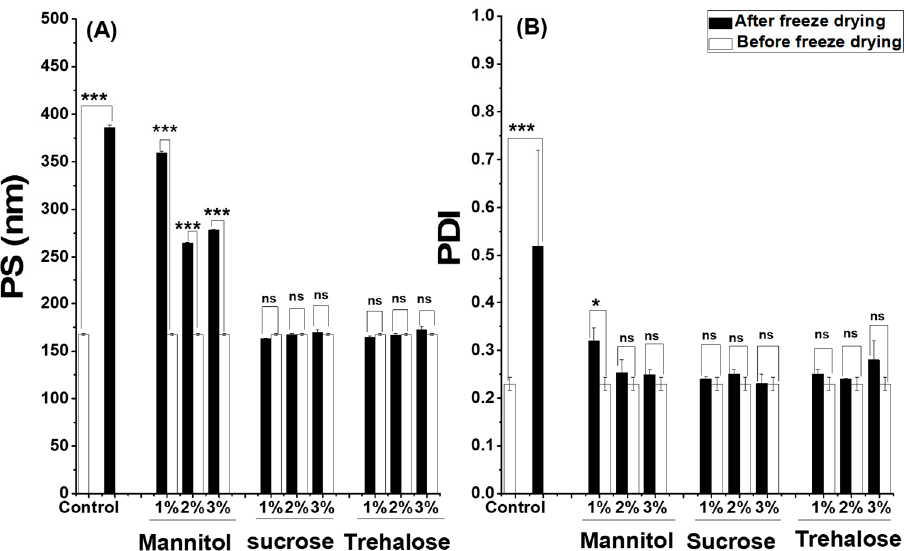
Figure 4. Influence of the freeze-drying process of SML-ANPs (10 mg/mL) in the presence of different excipients on ( A ) particle diameter and ( B ) polydispersity before freeze drying and after reconstitution of the samples in water (mean ± S.D.; n in each group = 3). For all results, ns presents that no significant differences were found and the differences were considered significant when p < 0.05, and extremely significant when p < 0.0001 presented by *, and ***, respectively.